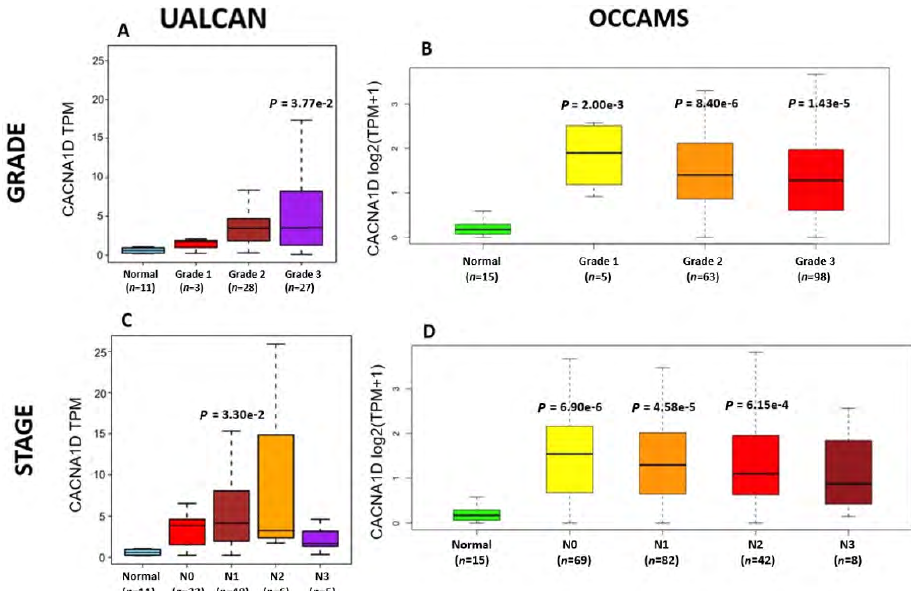
Figure 7. OAC tumor grade and nodal metastatic stage boxplots for CACNA1D . A). (UALCAN data) and B). (OCCAMS data) show CACNA1D -expression across various OAC-tumor grades, compared to normal tissue. C). (UALCAN data) and D). (OCCAMS data) show CACNA1D -expression across various nodal-metastatic stages, compared to normal tissue. A P -value of < 0.05 was considered statistically significant for the boxplots. Tukey HSD post hoc tests were adjusted for MOT. The number of tumor tissue, normal tissue (OCCAMS), or NAT (UALCAN) samples is represented by n